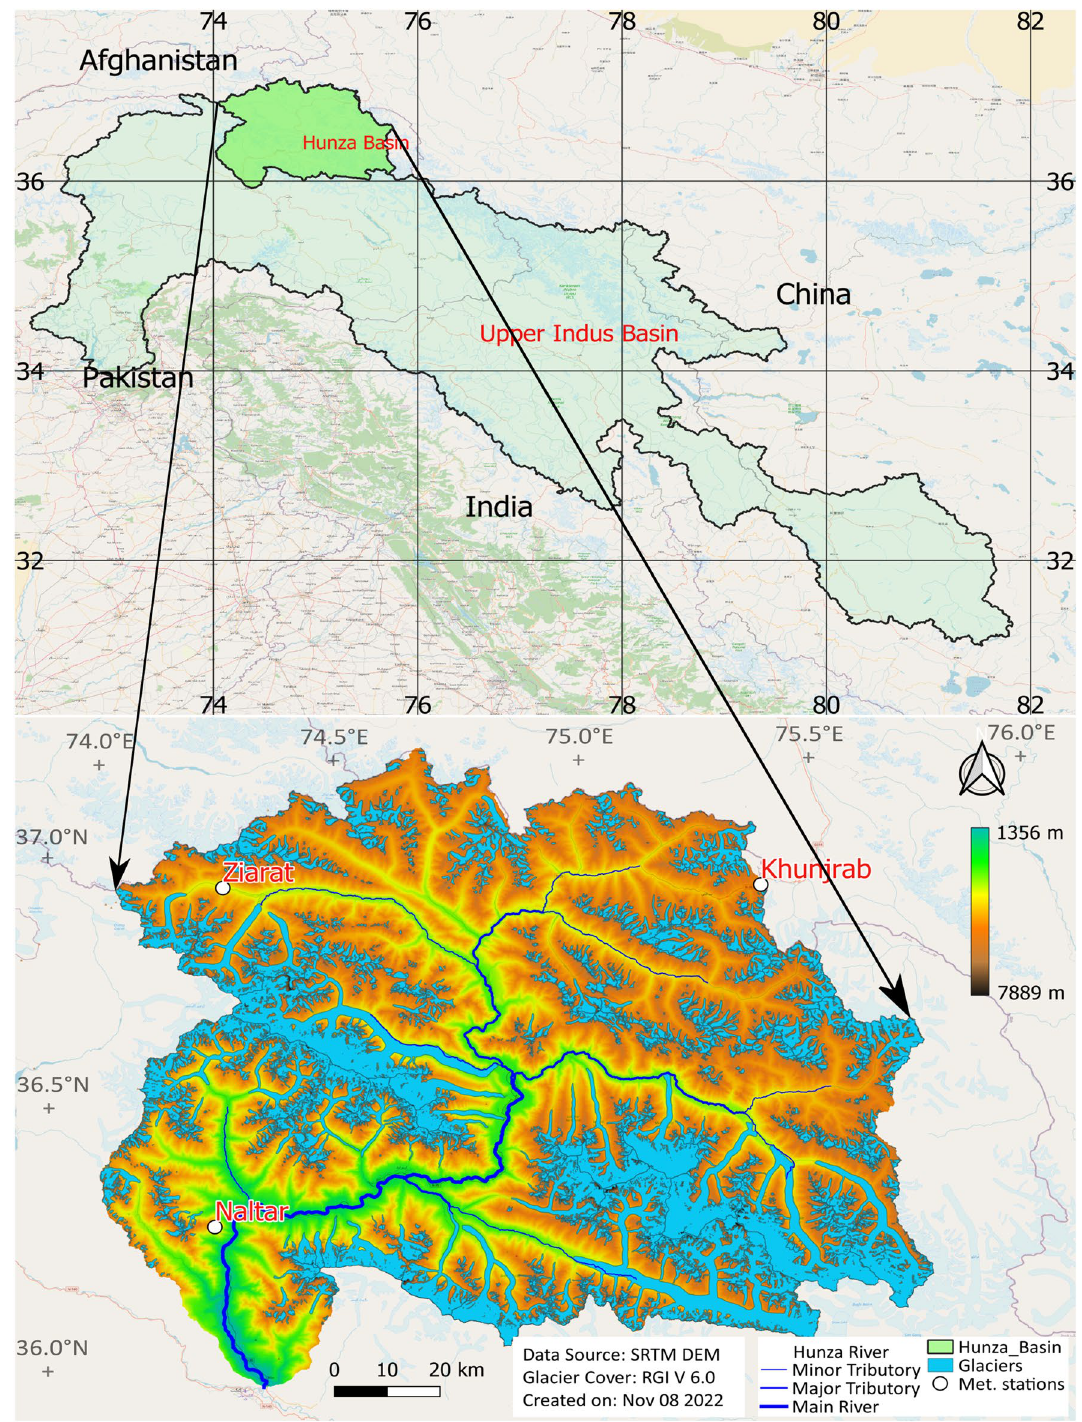
Figure 6. Location of the study area, glacier extent, river network and meteorological